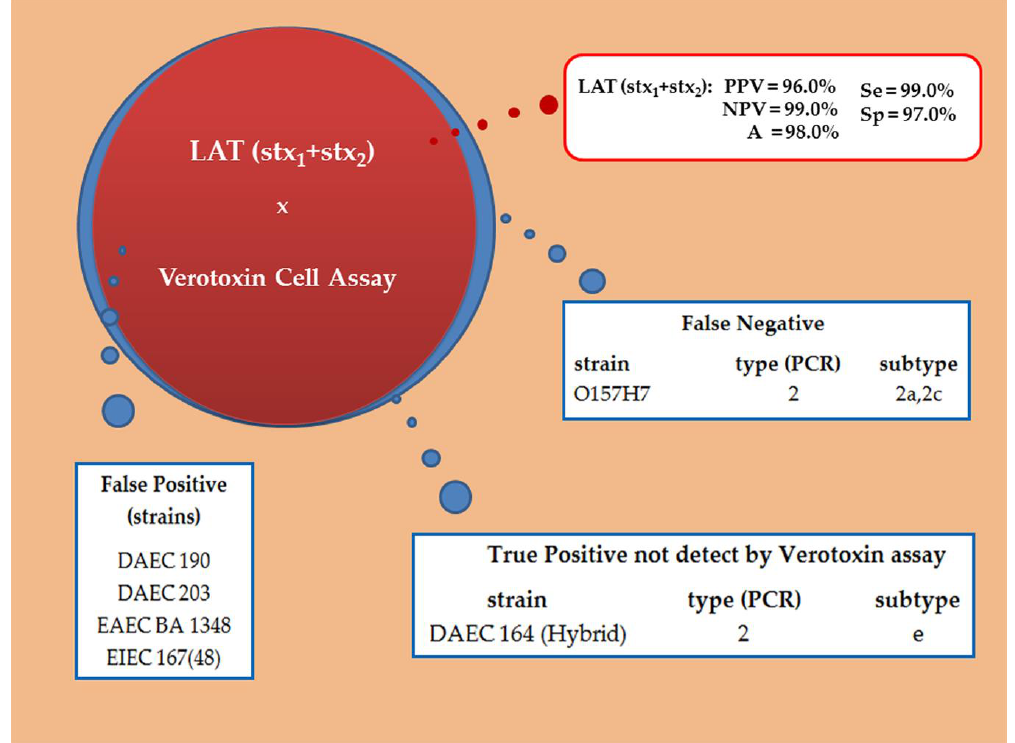
Figure 4. Venn diagram of latex agglutination test (LAT) employing Stx 1 mAb combined with Stx 2 mAb; PPV = positive predictive value; NPV = negative predictive value; A = accuracy; Se = sensitivity and Sp= specificity. Blue = VCA results; Red = LAT results.